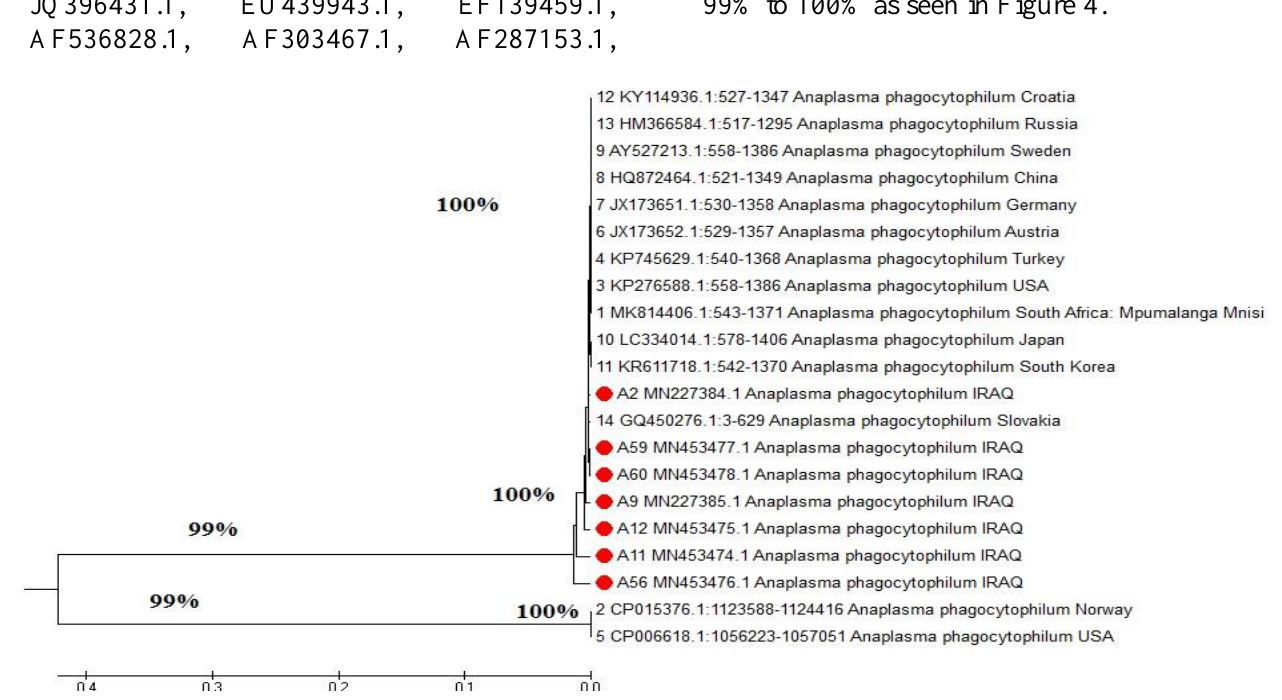
Figure 3. Neighbor-joining tree of A. phagocytophilum using the 16S rRNA gene. The above gene of A. phagocytophilum in the Iraqi isolates is represented by red circles compared with that of the 15 related strains deposited in the Genbank